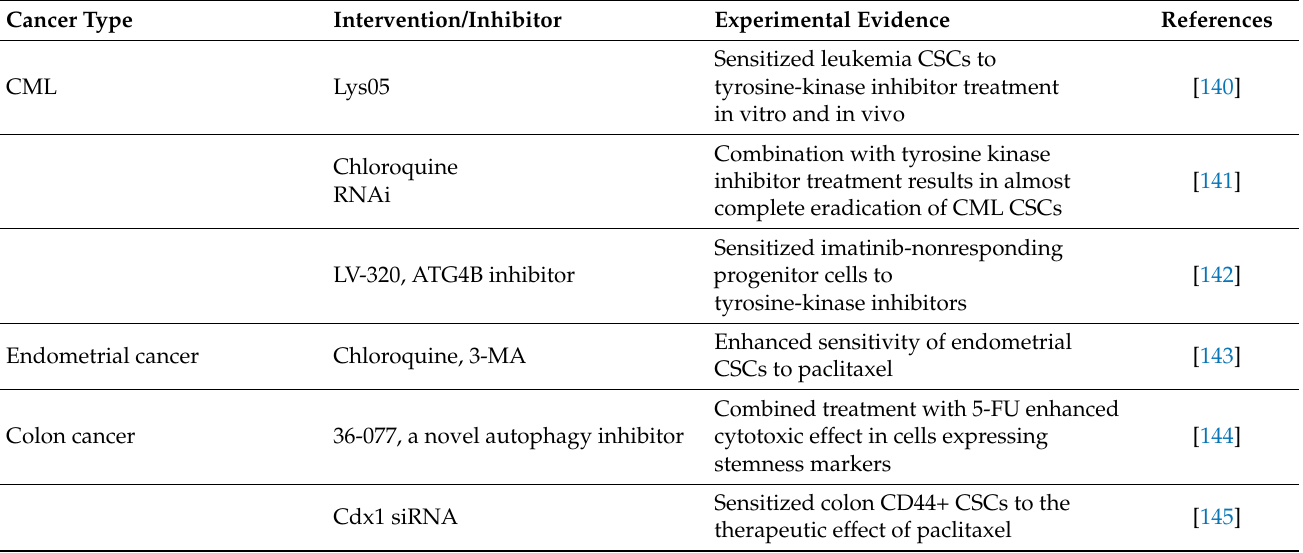
Table 5. Summary of evidence for the role of autophagy microenvironment in chemoresistance of cancer stem